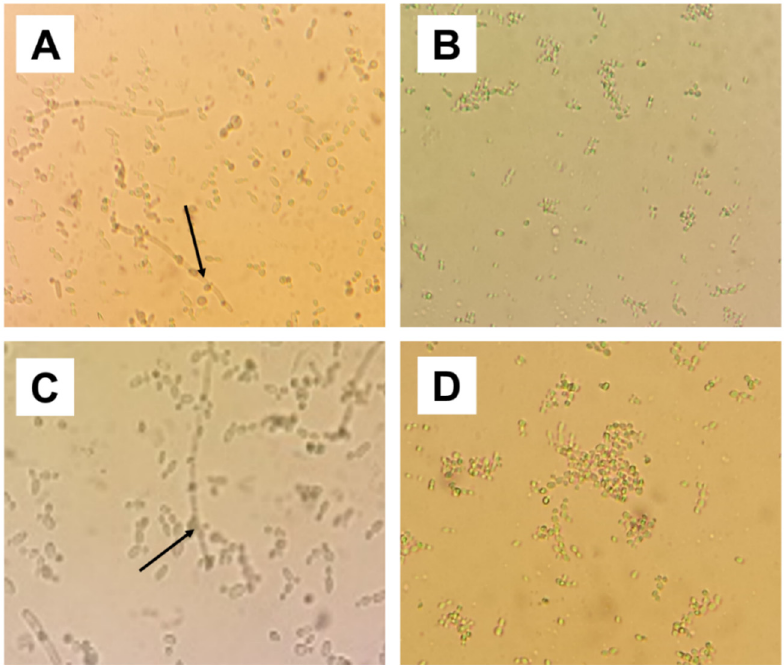
Figure 2. Micromorphology analysis. ( A ) C. albicans ATCC 76485 in the absence of isoeugenol (negative control), showing virulence structures of pseudo-hyphae and blastoconidia. ( B ) C. albicans ATCC 76485 treated with isoeugenol, there is a lack of pseudo-hyphae and a reduced number of blastoconidia. ( C ) C. albicans LM-4b in the absence of isoeugenol (negative control), showing a large amount of blastoconidia and pseudo-hyphae. ( D ) C. albicans LM-4b under the e ff ect of isoeugenol, absence of blastoconidia. Black arrow: Chlamydocide resistance structures.